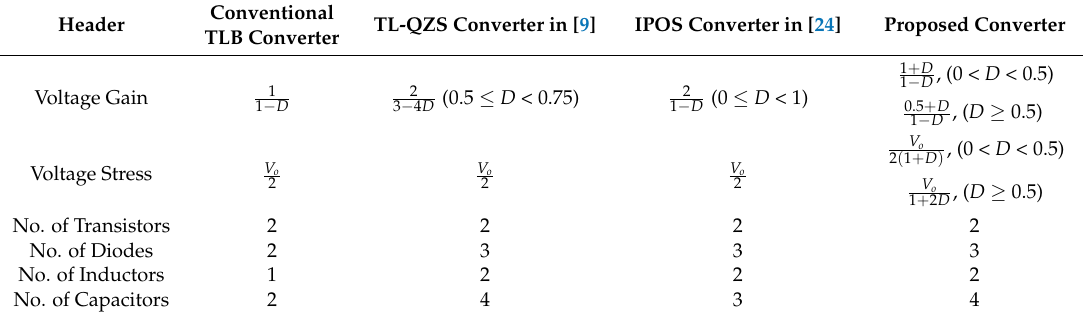
Table 1. Comparisons between the proposed converter and other step-up solutions without magnetic coupling. TLB: three-level boost; TL-QZS: three-level quasi-z-source; and IPOS: